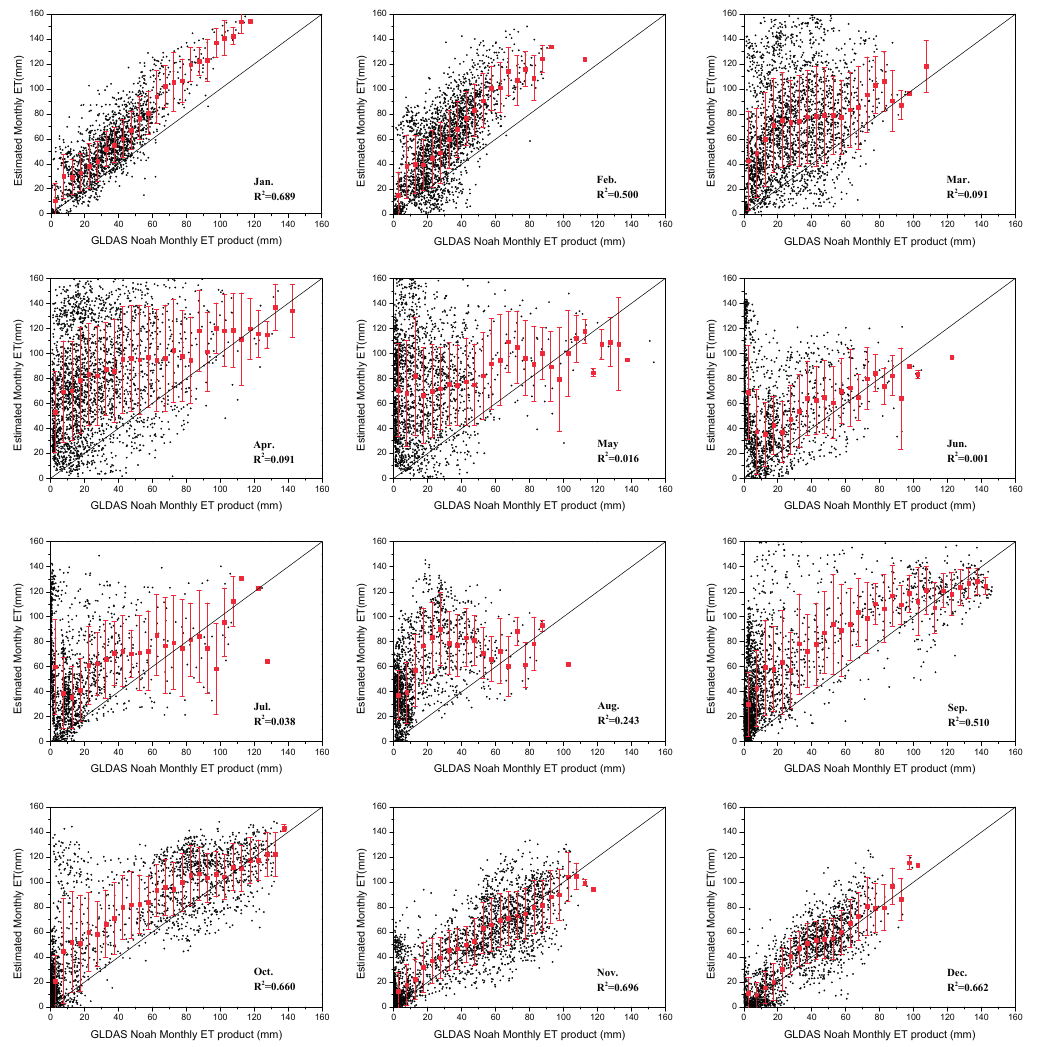
Figure 5. Scatter plot between estimated monthly ET and the NOAH GLDAS monthly product in